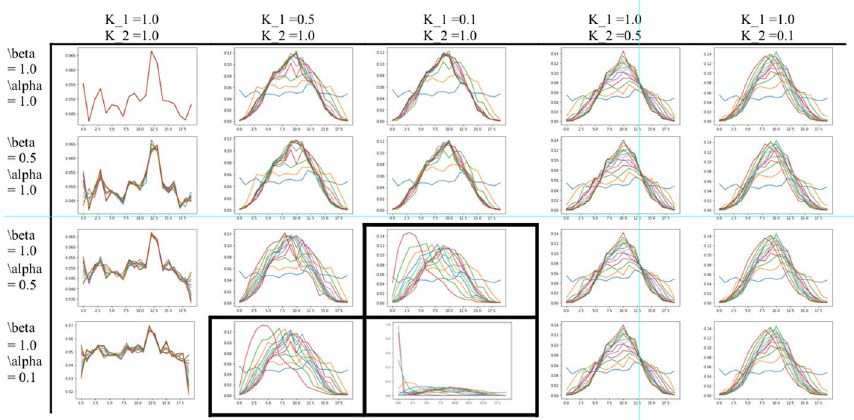
Fig. 4 Sensitivity analysis in the close boundary. The random seeds, based on a uniform distribution, were set to obtain the same initial arrays. Subfigures in lines show variations in the scale parameters, and columns show variations in the size parameters. Different colors in each plot represent iterations, starting from a uniform distribution. The model validation uses the parameters K 1